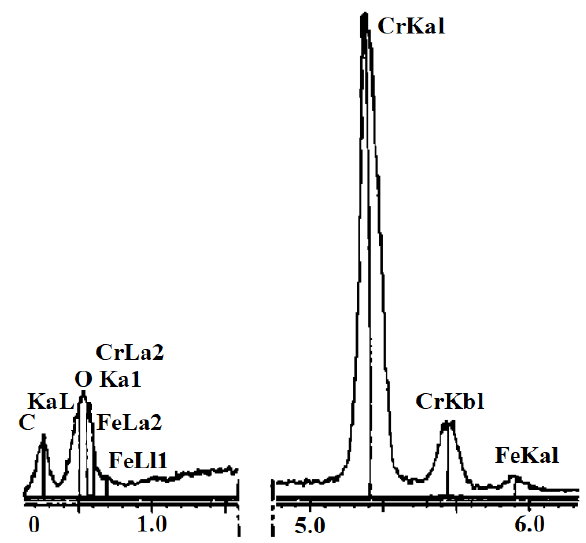
Figure 10. EDS spectrum of intermediate products [25]. Reproduced with permission from Xiao et al., Transactions of the China Welding Institution, 2001. Metals 2018 , 8 , x FOR PEER REVIEW